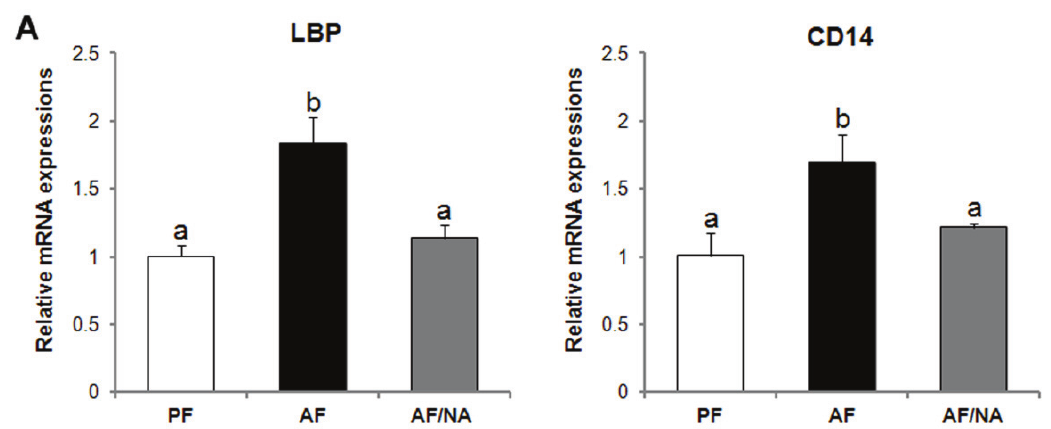
Figure 1. Plasma endotoxin levels in rats fed alcohol with or without nicotinic acid supplementation for 8 weeks. Endotoxin levels were measured by the limulus ameobocyte lysate method. Results are means ± SD ( n = 6–8). Significant differences ( p < 0.05, ANOVA) are identified by different letters. PF: pair-fed; AF: alcohol-fed; AF/NA: alcohol-fed with nicotinic acid